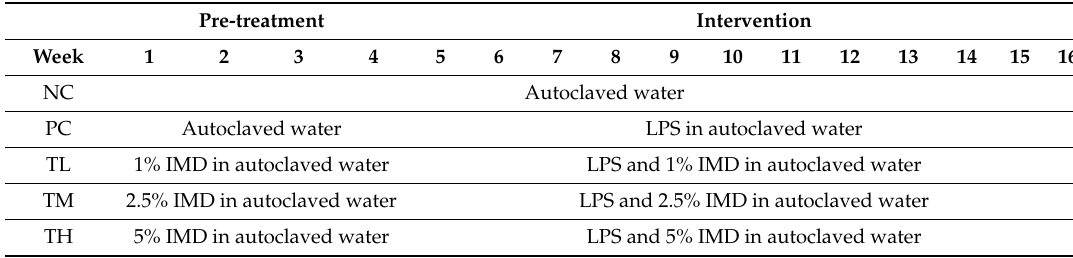
Table 1. Experimental design for the animal